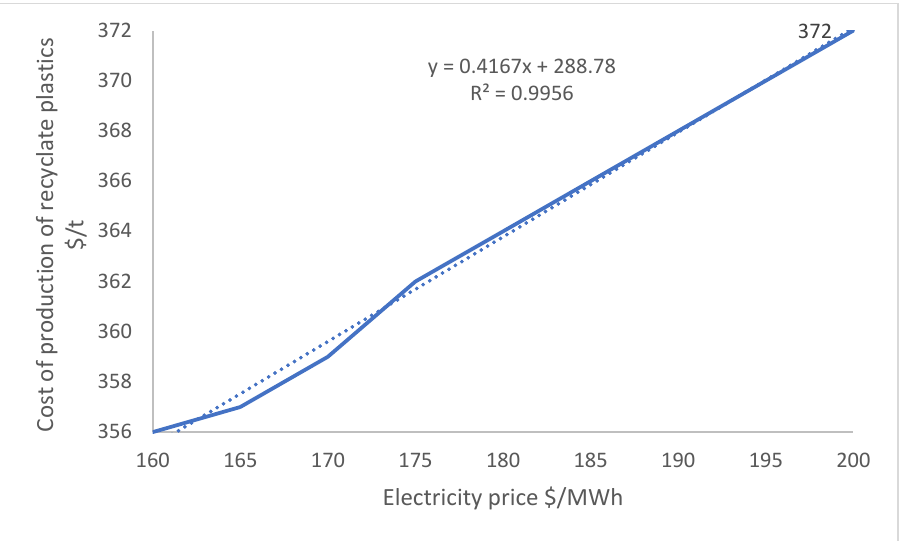
Figure 6. The effect of electricity price reductions on the cost of production of recyclate plastics.